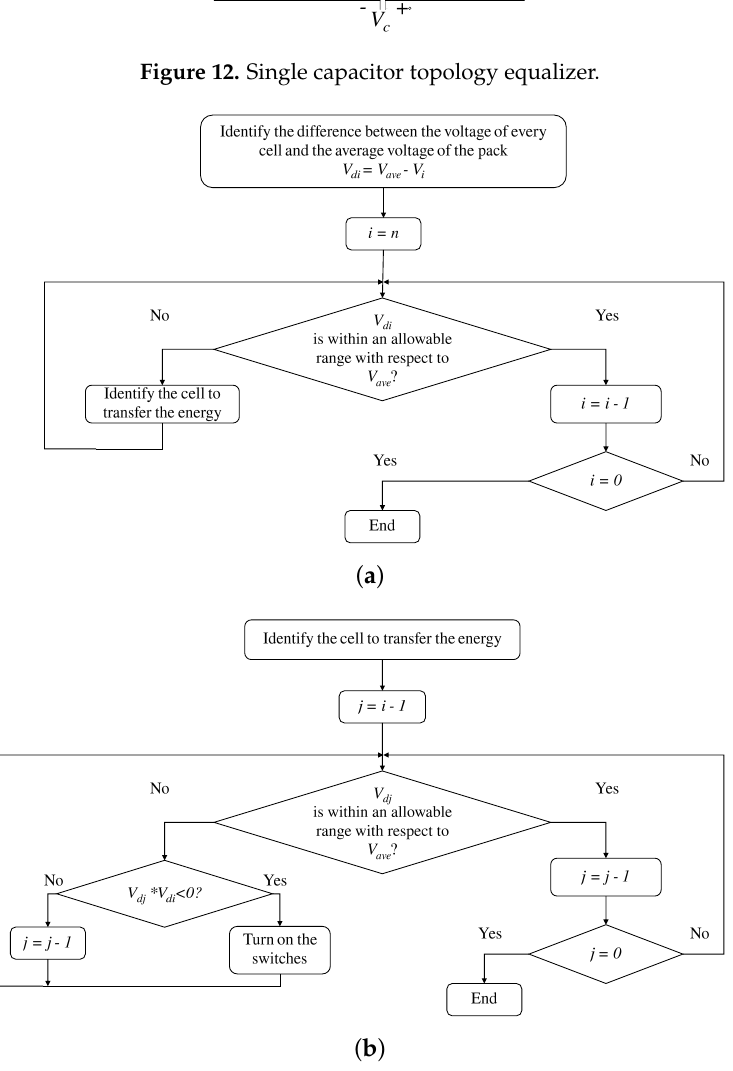
Figure 13. Algorithm required to equalize the battery bank: ( a ) general diagram; ( b ) function of the general